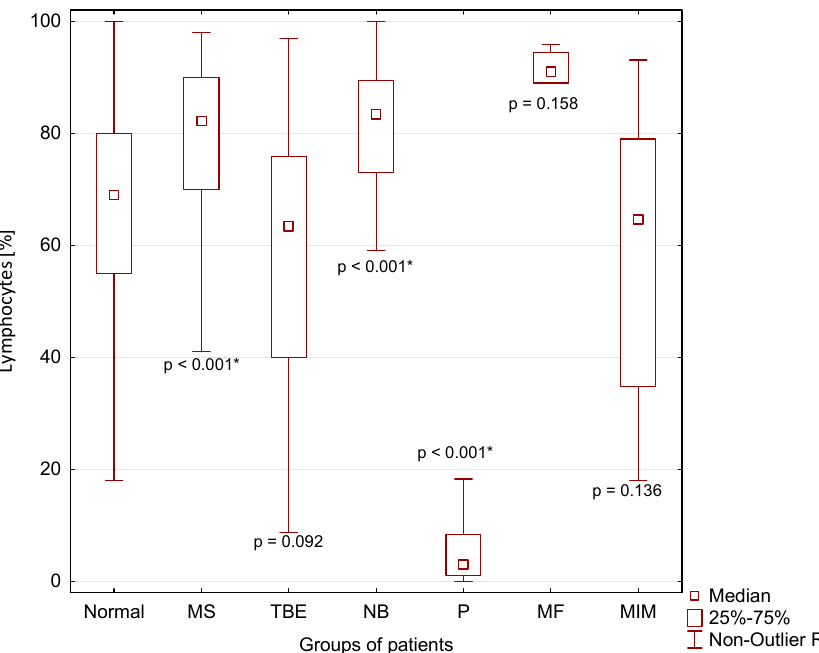
Figure 4. Percentage of lymphocytes in CSF in our patient groups (*: statistically significant). A significantly higher percentage of neutrophils in CSF compared to normal CSF findings was found in patients with TBE ( p < 0.001), NB ( p = 0.003), P ( p < 0.001) and MIM ( p > 0.001). The absolute highest neutrophil count is typical for patients with purulent in- flammation in the CNS (P) (Figure 5).